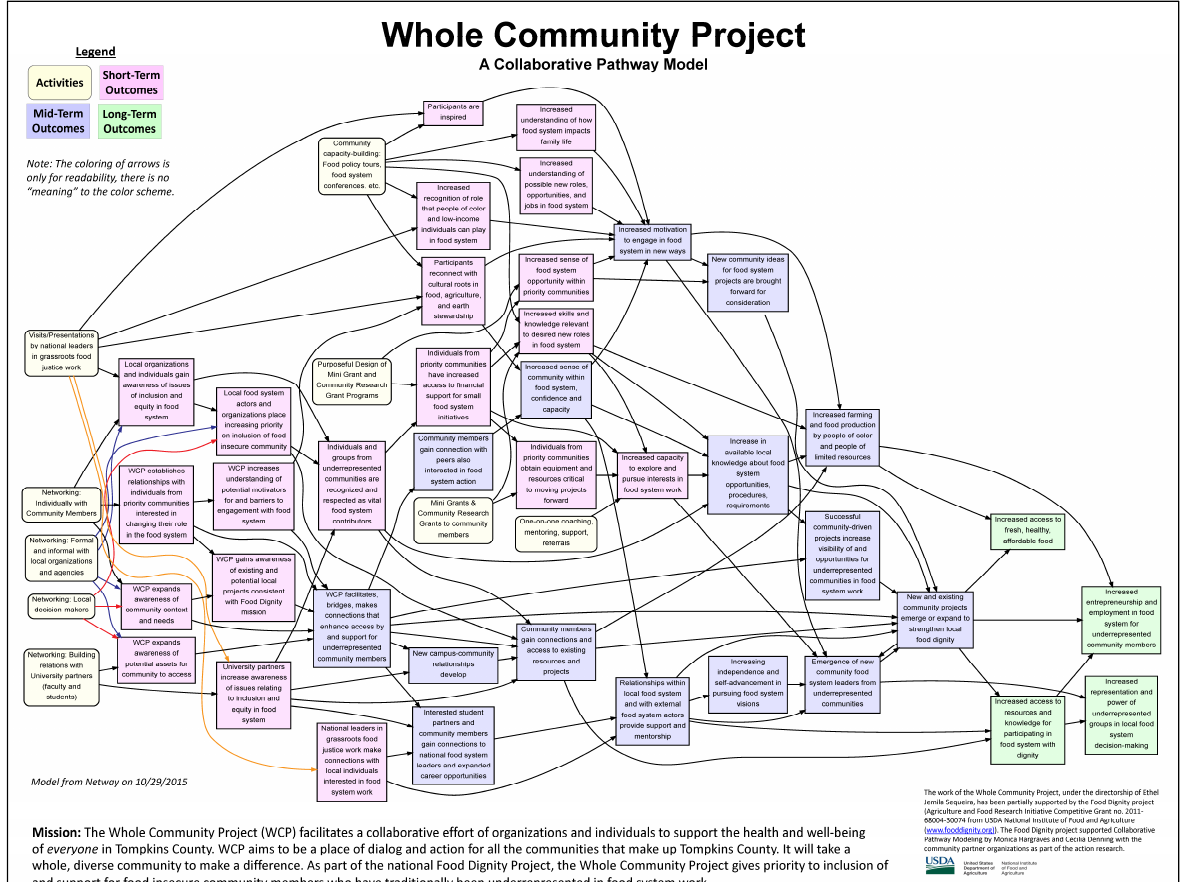
Figure 1. Collaborative Pathway Model Poster of the Whole Community Project (Ithaca, New